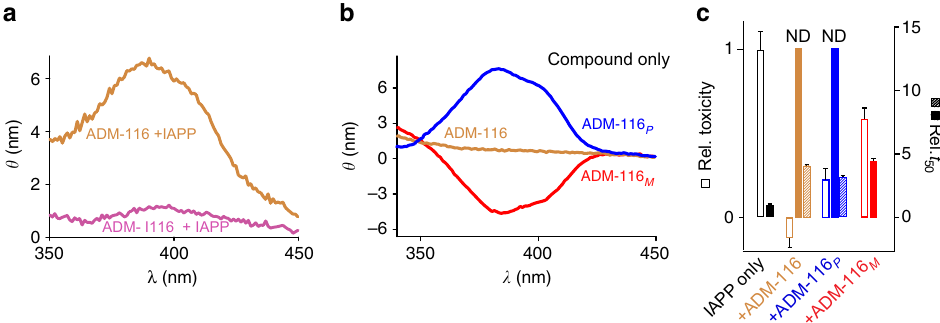
Figure 8 | Selection, perturbation and activity of ADM-116 enantiomers. ( a ) Visible CD of 25 m M ADM-116 or ADM-|116 in the presence of 25 m M IAPP. ( b ) Visible CD of ADM-116 and each of two chiral variants designed to introduce bias into the ADM-116 enantiomer distribution. ( c ) Comparison of the fibre formation inhibition (closed) and toxic rescue (open) activities of enantiomer-biased constructs of ADM-116. Experimental conditions match those used in Fig. 3 and Fig. 4, respectively. Fibre formation inhibition also shown for inhibition of reactions conducted at 10:1 IAPP:small molecule (hash). NATURE COMMUNICATIONS|7:11412|DOI: